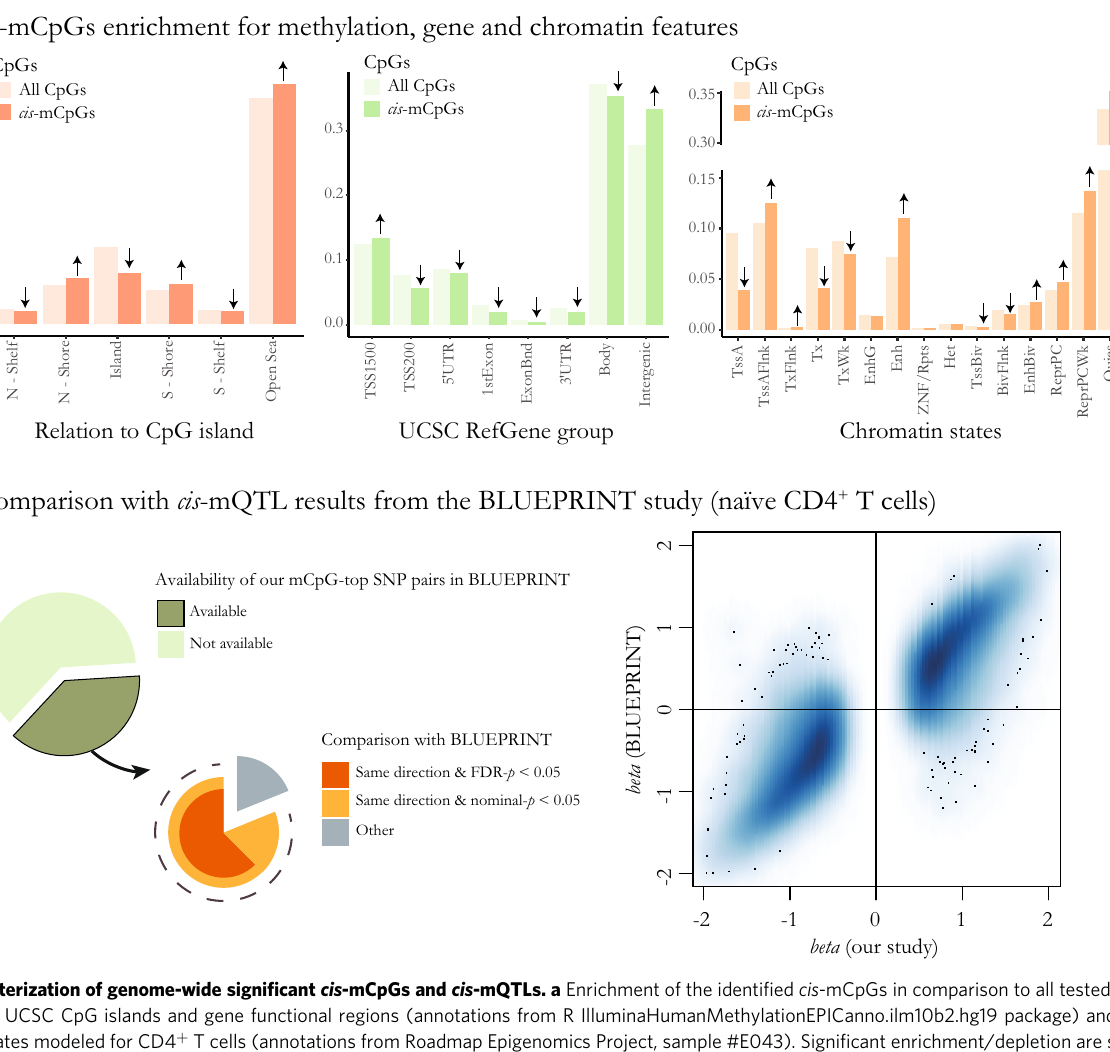
ison to CD4 + T cells of MS patients ( p = 2.68 × 10 − 10 , our study).